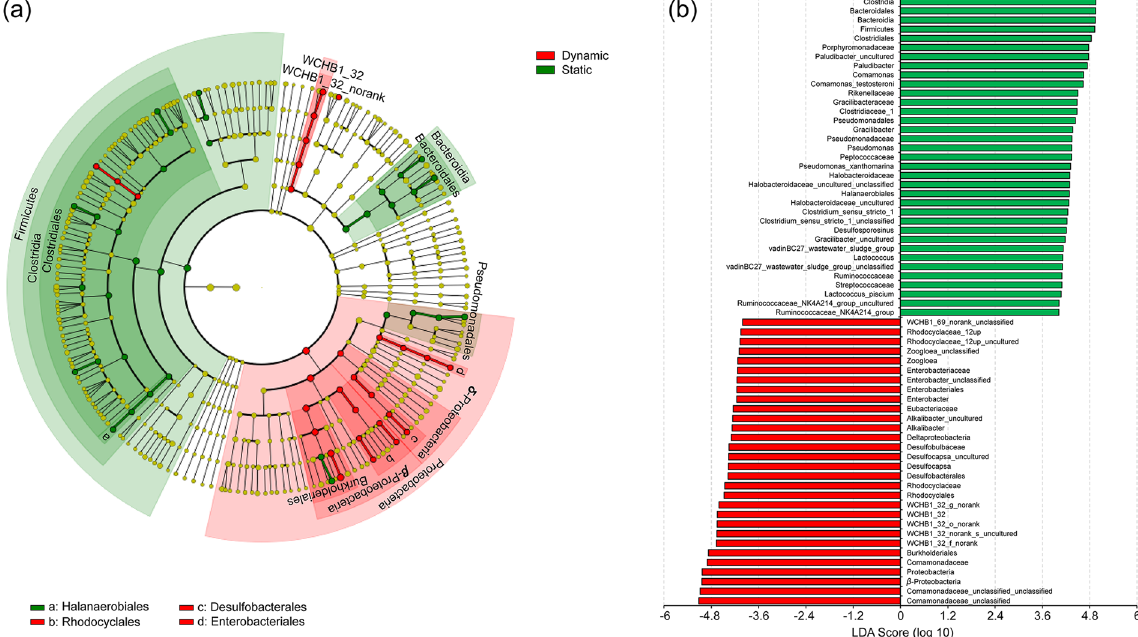
Figure 9. ( a ) Cladogram indicating the phylogenetic distribution of microbial lineages associated with sediments under static water conditions (green) and dynamic water flow conditions (red); and ( b ) indicator microbial groups with LDA values greater than